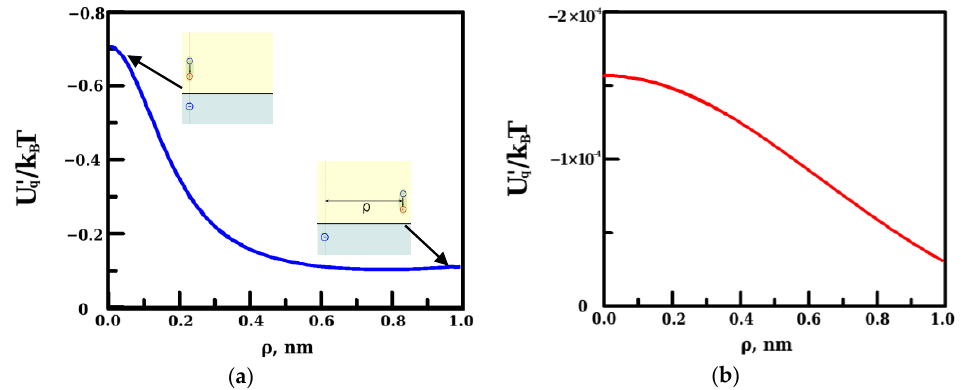
Figure 2. ( a ) The energy of interaction between the dipole of solute water molecule and a discretely charged water/alkane interface with accounting for all polarization effects, as a function of dipole location with respect to a given surface charge; and ( b ) the thickness dependent part of the energy presented in ( a ).